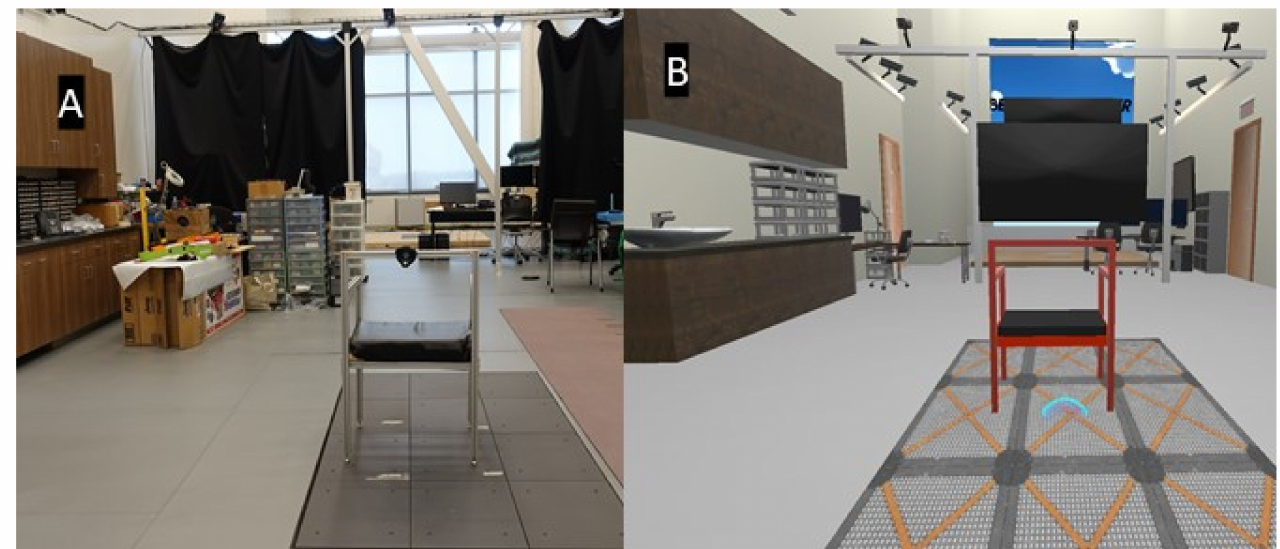
Figure 1. Representation of the environment in ( A ) real world and, ( B ) Virtual